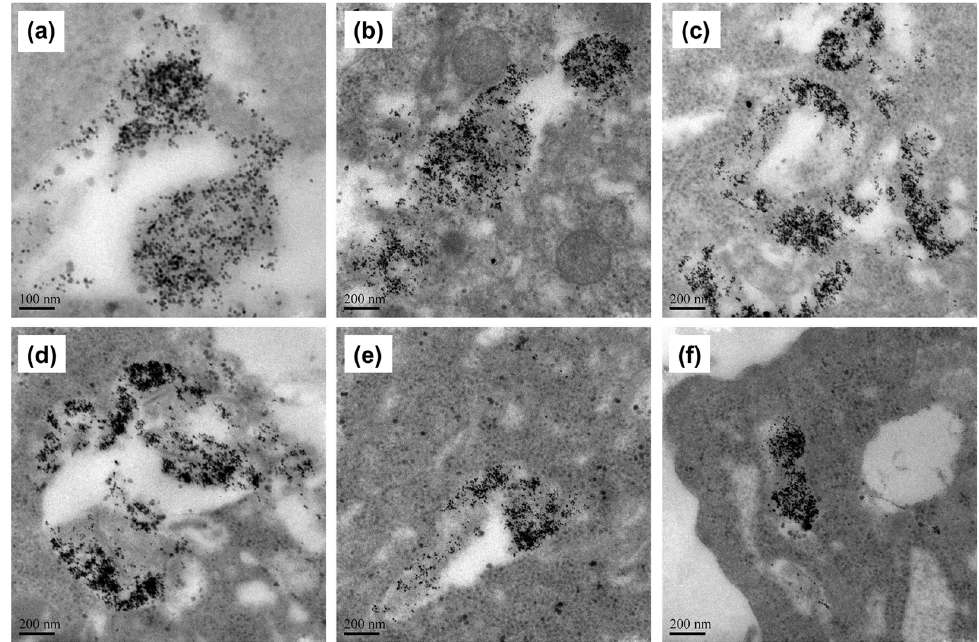
Figure 22. TEM images of SMMC-7721 cells treated with ( a , d ) Fe 3 O 4 -PAA, ( b , e ) Fe 3 O 4 -Ag-PAA, ( c , f ) or Fe 3 O 4 @Ag-PAA NPs for 12 h with and without alternating current magnetic field treatment. Reproduced with permission from reference [79]. Copyright 2017 Elsevier.